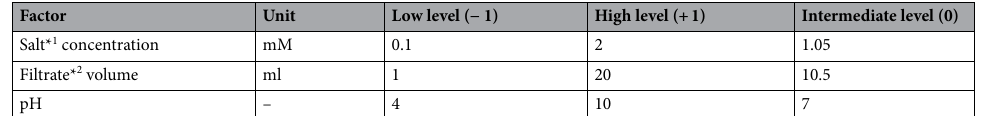
Table 1. Levels of factors selected for optimization study using Box-Behnken design. * 1 FeSo 4 ·7 H 2 O. * 2 Aspergillus flavipes MN956655.1 Culture filtrate.